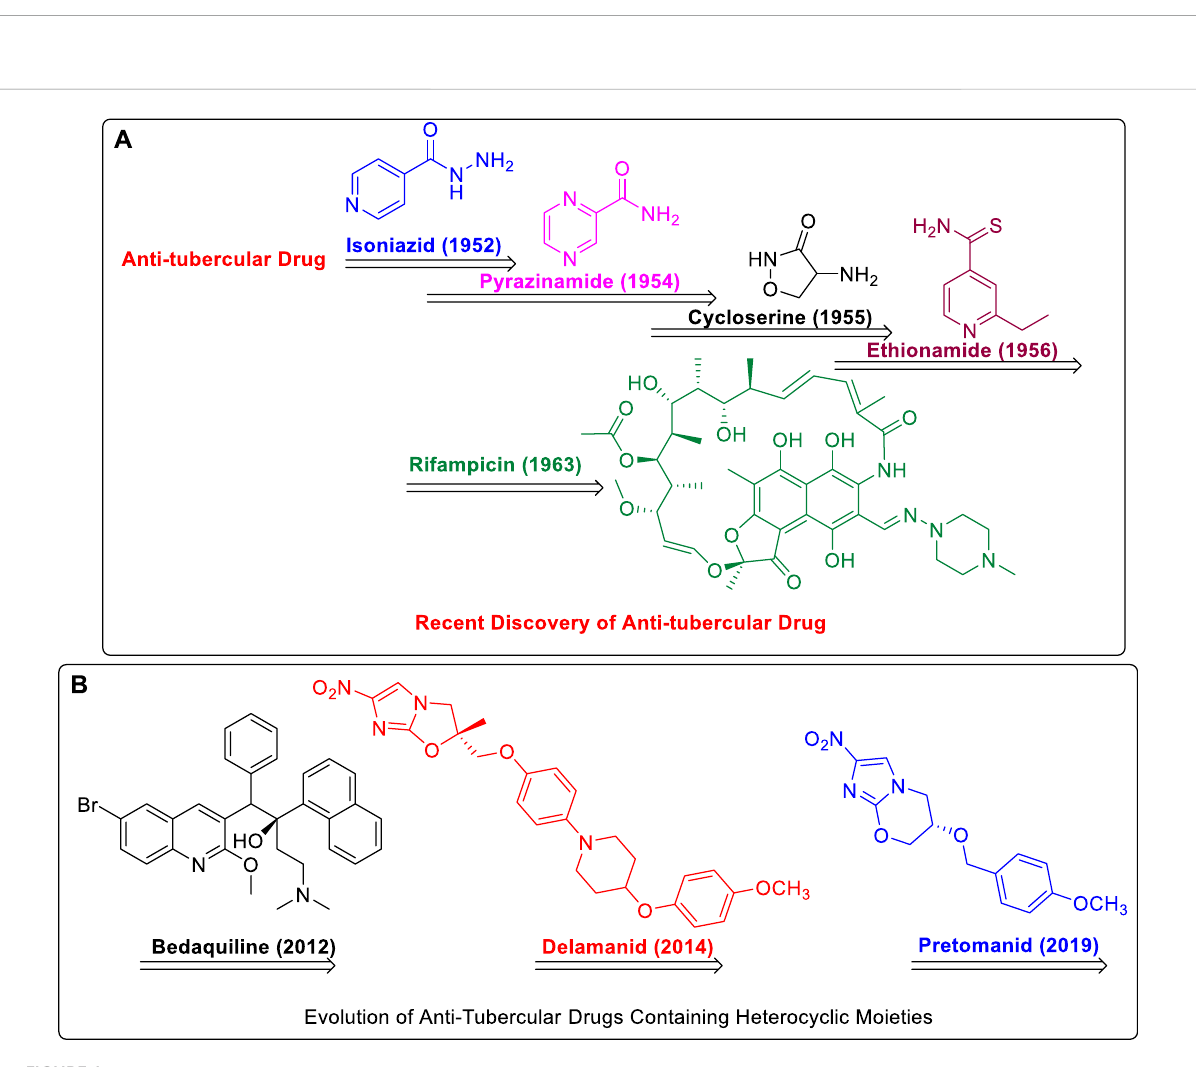
FIGURE 1 (A) Recent Discovery of Anti-Tubercular Drugs. (B) Evolution of Anti-Tubercular Drugs Containing Heterocyclic